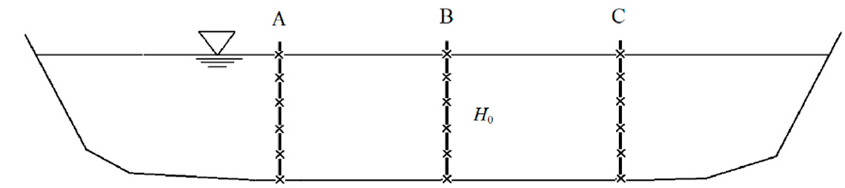
Figure 3. Schematic diagram of cross-sectional measurement points (looking downstream).